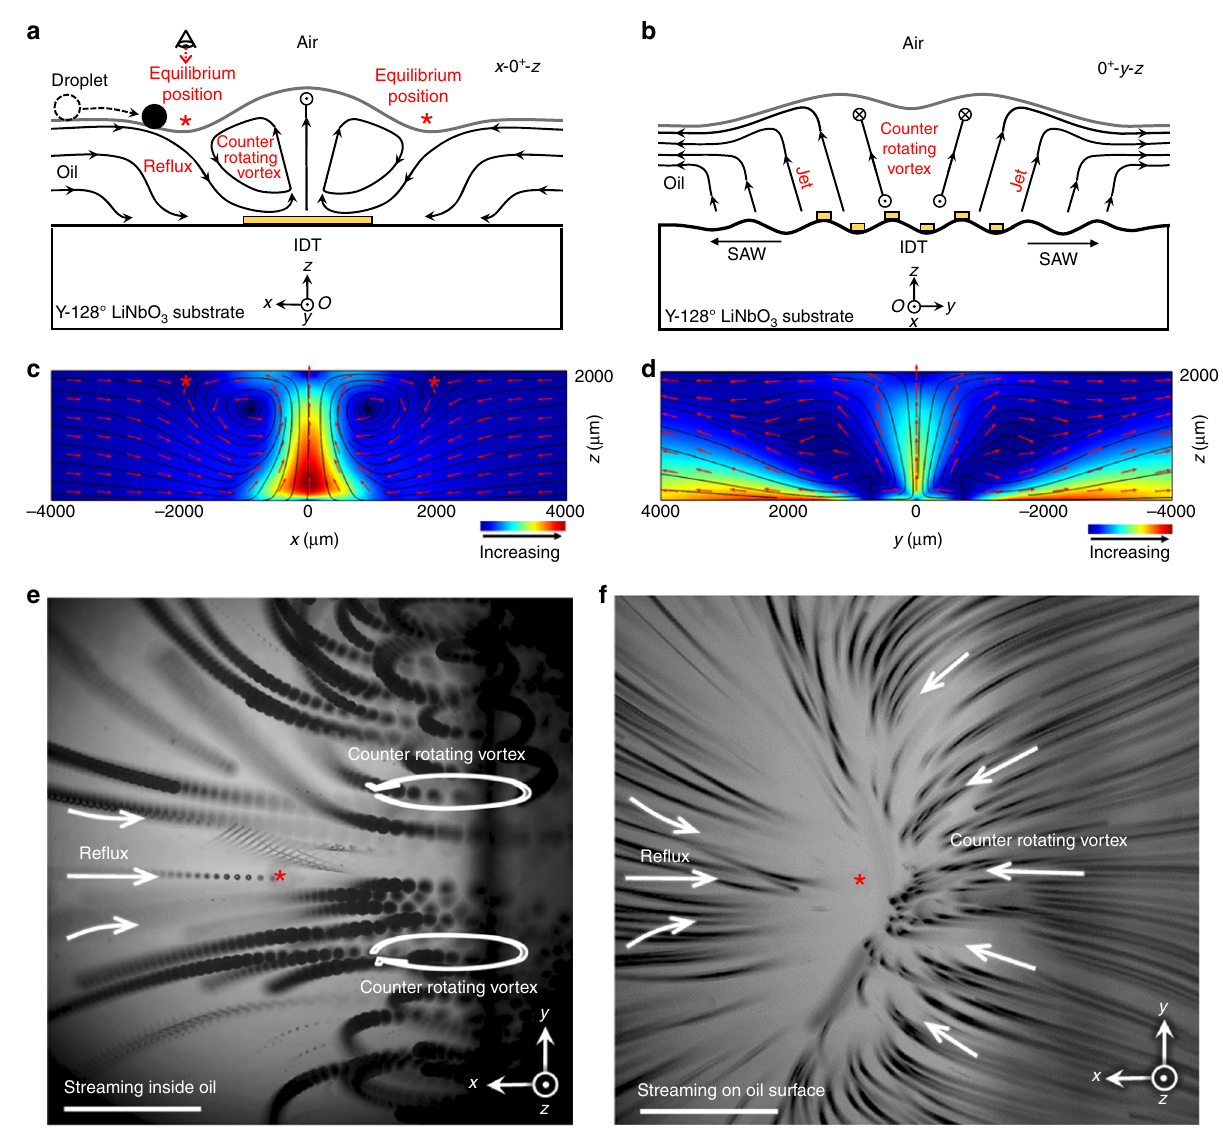
Fig. 2 Mechanism of hydrodynamic traps. a x – z -plane cross-sectional view of the streaming pattern at an IDT (at y = 0 + ). The IDT pumps out the carrier fl uid in ± x directions. The origin ( O ) is located at the center of the IDT on the x – y -plane. The re fl ux pulls the droplet toward the IDT in the far fi eld, and then the counter-rotating vortex near the side of the IDT resists this re fl ux and fi nally stabilizes the droplet. The red asterisks indicate the symmetric hydrodynamic equilibrium positions on the surface of the carrier oil. b y – z -plane cross-sections of the streaming pattern at an IDT (at x = 0 + ). The IDT pumps in the carrier fl uid in the ± y directions. The waves propagating around the carrier fl uid generated two symmetric jet fl ows with an incident angle of 34° with respect to the IDT aperture. c Simulation results showing the acoustic streaming patterns in the x – z -plane. The counter-rotating vortices resist the re fl ux and form two hydrodynamic traps near the sides of the transducer (as indicated by the red asterisks). d Simulation results showing the acoustic streaming patterns in the y – z -plane. The acoustic energy from the IDT coupled into the oil layer above it and pumped out fl uid in the ± y directions. e , f Stacked images of particle trajectories near one fl ank of an activated IDT. This region corresponds to the area highlighted by the red circle in Fig. 1a. The reference perspective is also indicated by the eye symbol in a . e z = 1.3 mm, the focal plane is in the middle of the carrier fl uid layer. In this composite image, the re fl ux and the vortices of the counter fl ow are clearly visualized. The red asterisk indicates the hydrodynamic equilibrium position on the surface of the carrier layer of oil. f z = 2 mm, the focal plane of the microscope is fi xed to the surface of the oil layer. The counter-rotating vortices form a clamp- like pattern which pinches the droplet and keeps it from escaping in + y and − y directions. Scale bar: 750 μ